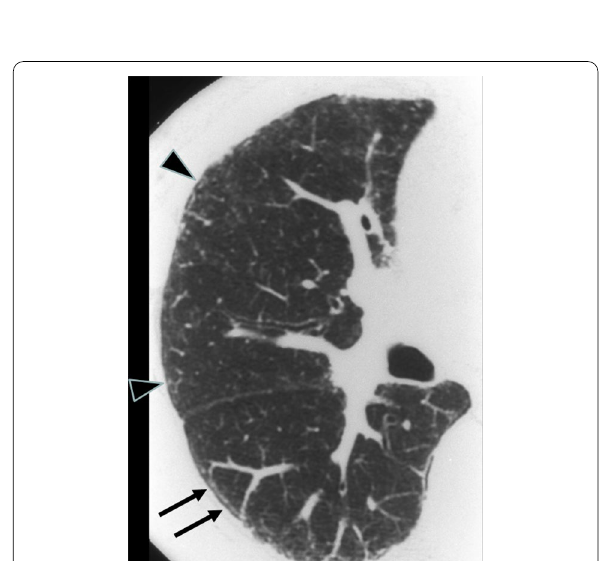
Fig. 1 Subpleural dots and subpleural lines in asbestosis. Some dots are located a few millimeters from the pleura (arrows). In asbestosis, subpleural line is much closer to the pleural surface and the distance of the subpleural lines from the inner chest wall is 2 to 3 mm (arrowheads). The subpleural lines look like connected subpleural dots arranged along the inner chest